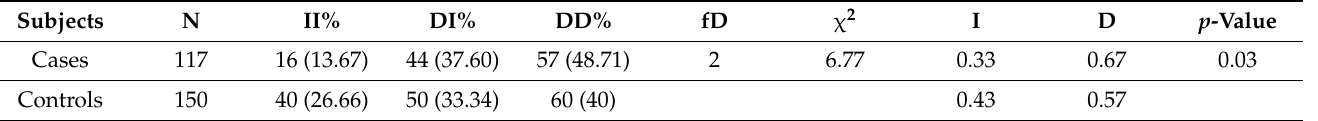
Table 3. Association of ACE2-rs4646994 I/D genotypes in COVID-19 severity.